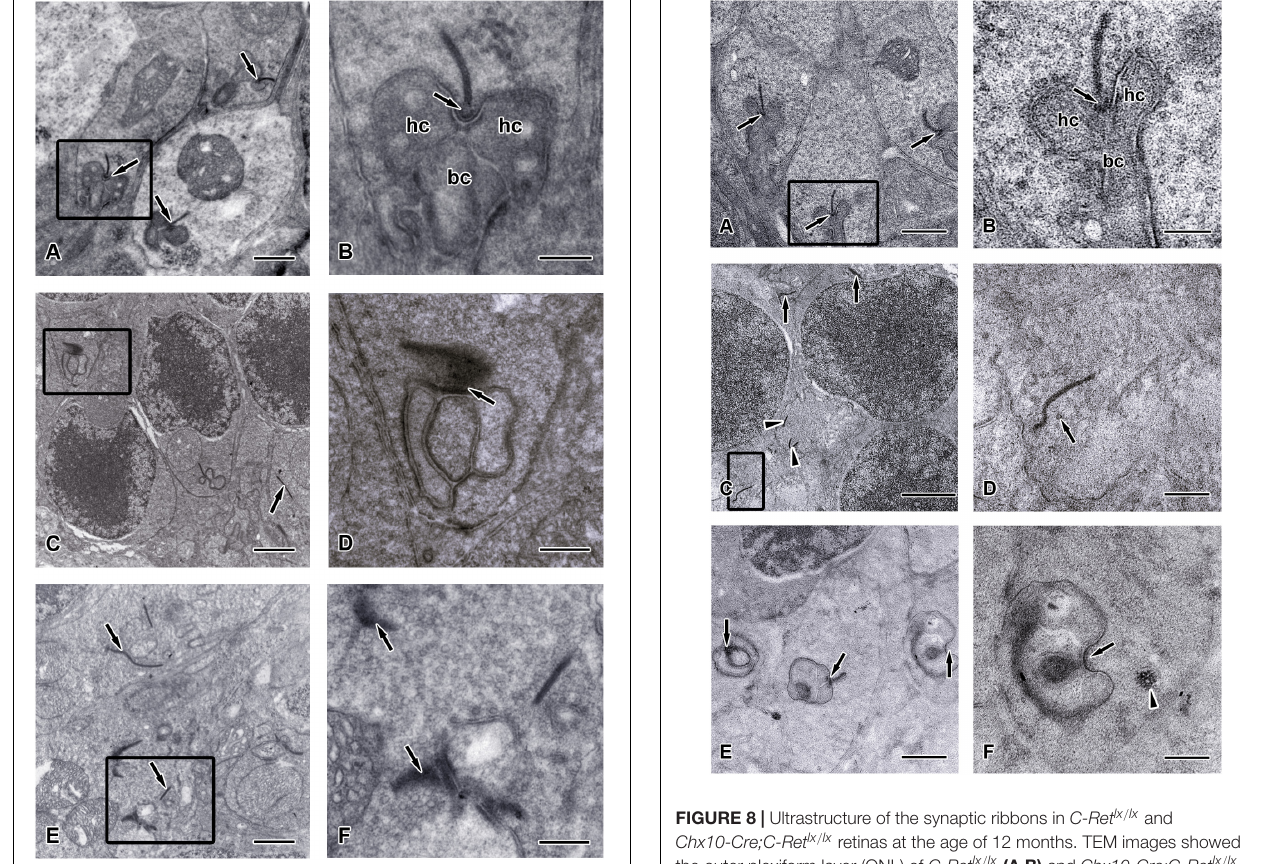
FIGURE 7 | Ultrastructure of the synaptic ribbons in C-Ret lx / lx and Chx10-Cre;C-Ret lx / lx retinas at the age of 2 months. Transmission electron microscopy (TEM) images showed the outer plexiform layer of C-Ret lx / lx (A,B) and Chx10-Cre;C-Ret lx / lx (C–F) mice at the age of 2 months. (A) Three typical rod-like synaptic ribbon profiles (arrows) with several mitochondria were observed in the pedicle of C-Ret lx / lx mice. (B) Higher magnification of the TEM image is shown in the rectangle of (A) . The electron dense synaptic ribbon was surrounded by a halo of synaptic vesicles. The arciform density (arrows) was positioned between the base of the ribbon and the plasma membrane. Three post-synaptic processes, two dendritic tips of horizontal cells (hc) and one dendritic tips of bipolar cells (bc), were closely apposed to the photoreceptor near the ribbon. (C,E) Most synaptic ribbons (arrows) in the rod spherules appeared to float in the cytoplasm, unassociated with an arciform density and the presynaptic membrane. (D) Higher magnification of the TEM image is shown in the rectangle of (C) . Synaptic structure in pedicle (arrow) of Chx10-Cre;C-Ret lx / lx retina was found to be dramatically different from that in the C-Ret lx / lx retina. (F) Higher magnification of the TEM image is shown in the rectangle of (E) . “Medusa-like” ribbons (arrows) were observed in which they displayed fewer postsynaptic processes that appeared to invaginate into a photoreceptor terminal. Scale bars: (A,C,E) , 1 µ m; (B,D,F) , 300 nm.